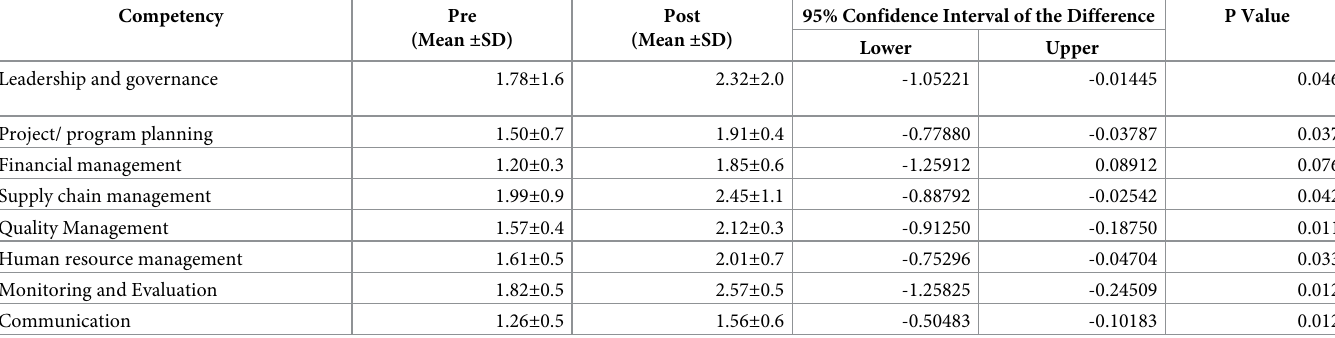
Table 4. Change in level of competency of participants of International Public Health Management Development